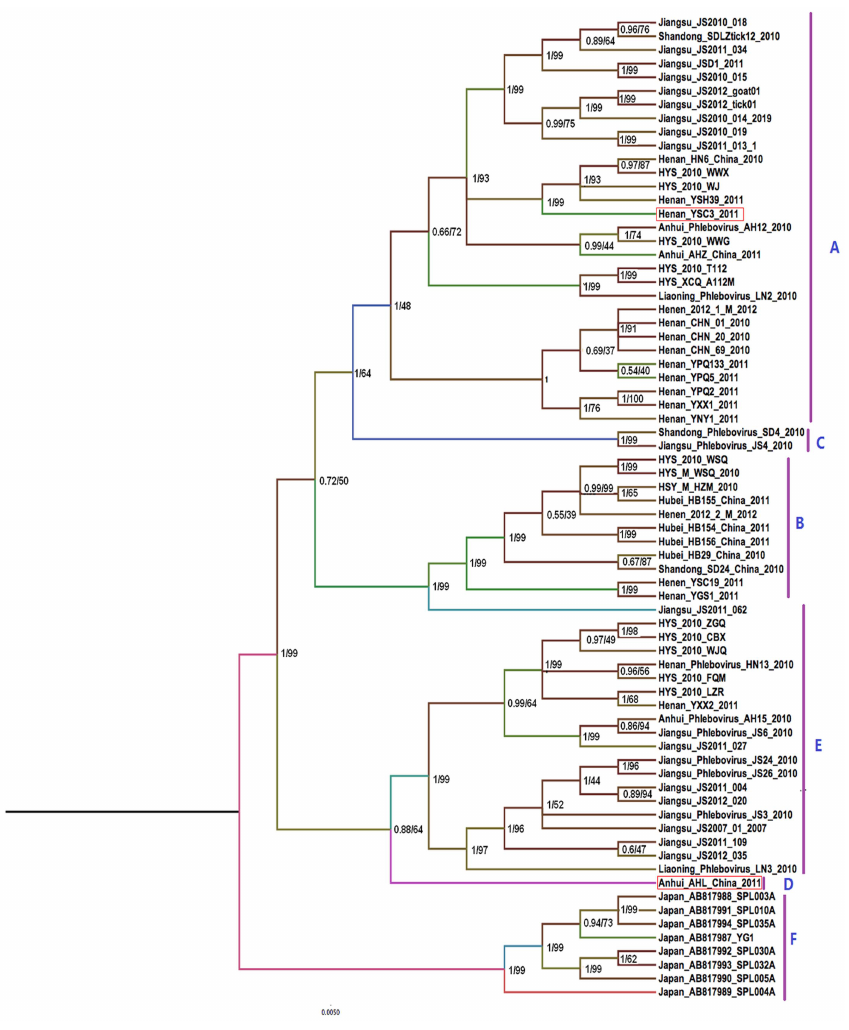
Figure 2. Bayesian coalescent and Maximum likelihood (ML) analysis of FTLSV based on the M segment. Maximum clade credibility and Maximum likelihood tree is shown with posterior probability values and bootstrap value depicted at the nodes. Phylogenetic analysis was carried out using Mrbayes 3.2.1 and Mega software 5, respectively. Designations of the different FTLSV phylogroups (A,B,C,D,E,F clade) are as indicated, based on previously defined assignments. These sequences are described in more detail in Table 1. The sequences from Japan were included in this